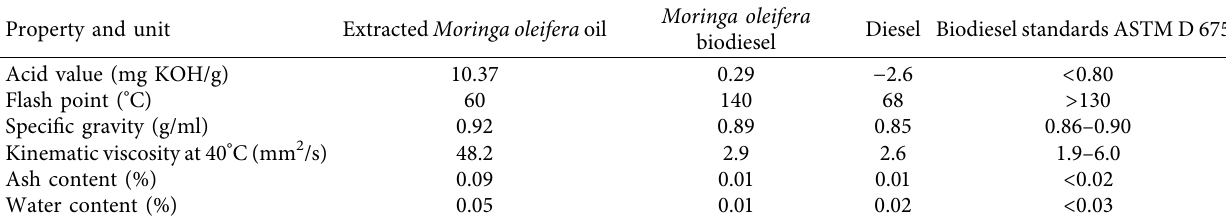
Table 7: Moringa oleifera biodiesel fuel properties with ASTM D6751 standard [7]. Property and